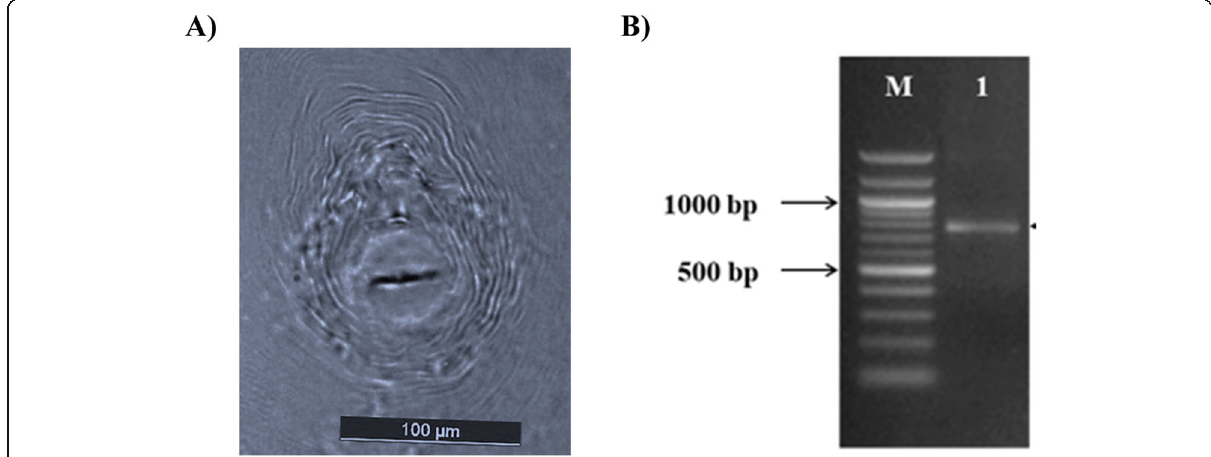
Fig. 1 Morphological identification ( a ) of southern root-knot nematode, Meloidogyne incognita using perineal pattern of mature female characterized by a high, squarish dorsal arch, a typical character of M. incognita and molecular validation ( b ) using PCR amplified